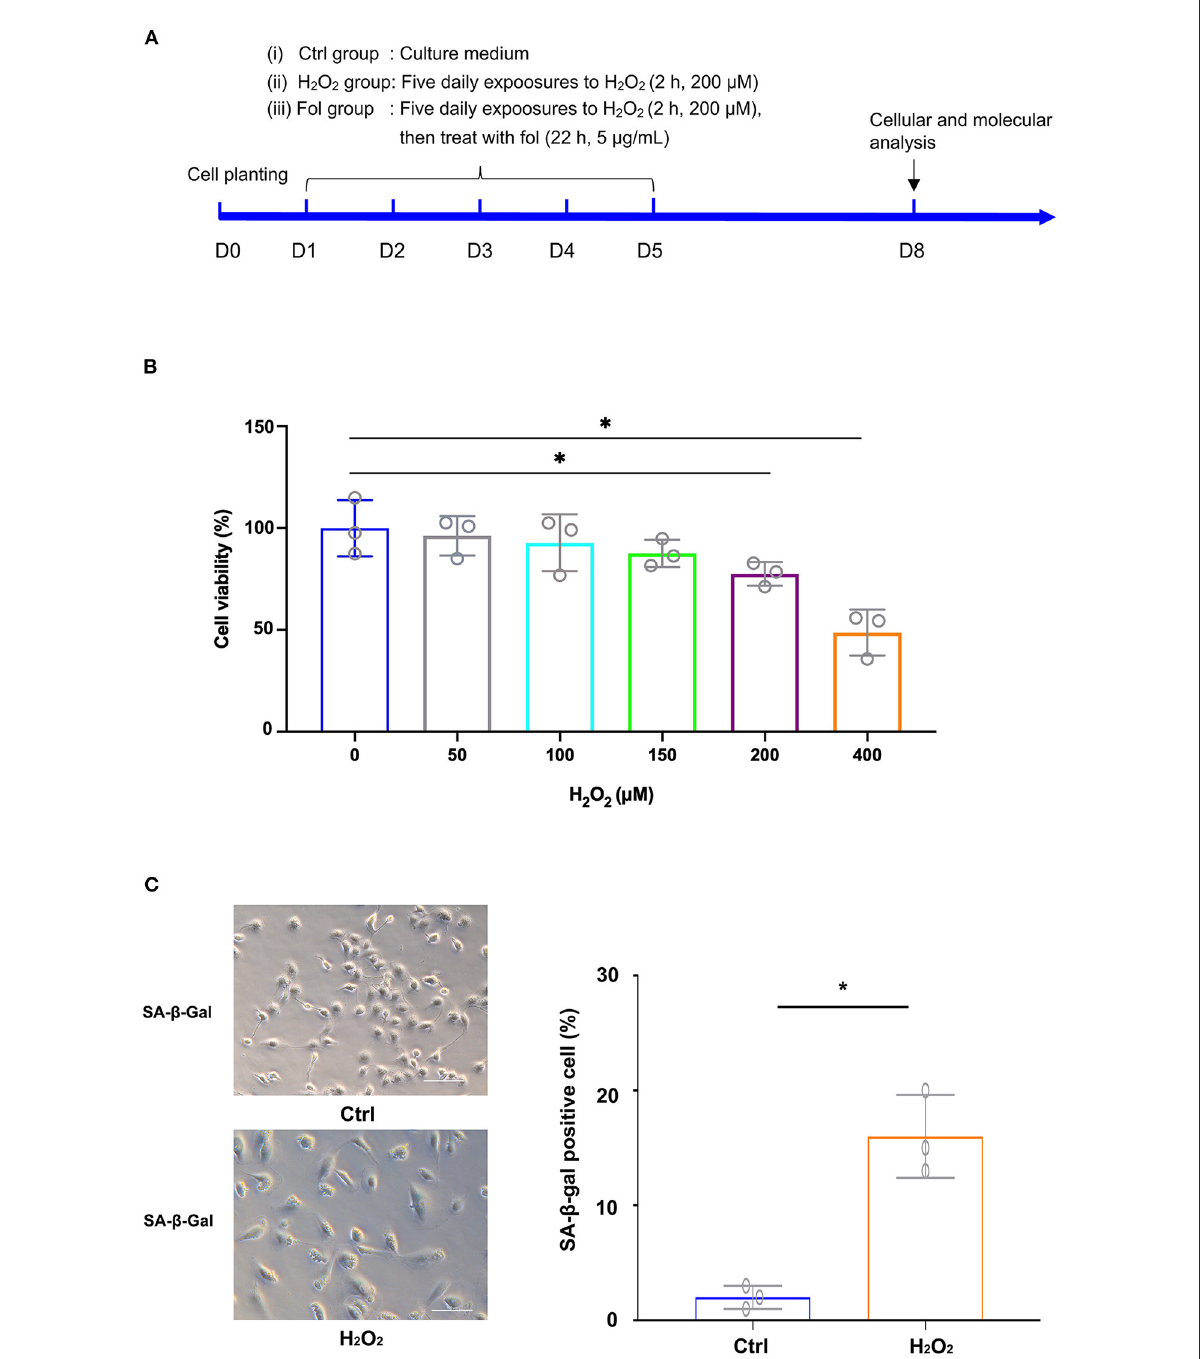
FIGURE1 H 2 O 2 -Induced Senescence in ARPE-19 Cells. (A) Experimental design and reference time frame. (B) ARPE-19 cells were treated with H 2 O 2 (50 µ M, 100 µ M, 150 µ M, 200 µ M, 400 µ M) for 2h daily. Cell viability was analyzed with the CCK8 method. (C) ARPE-19 cells in the control group and H 2 O 2 group of ARPE-19 cells were stained with senescence-associated β -galactosidase (SA- β -Gal). Fol, fullerenol; * p <